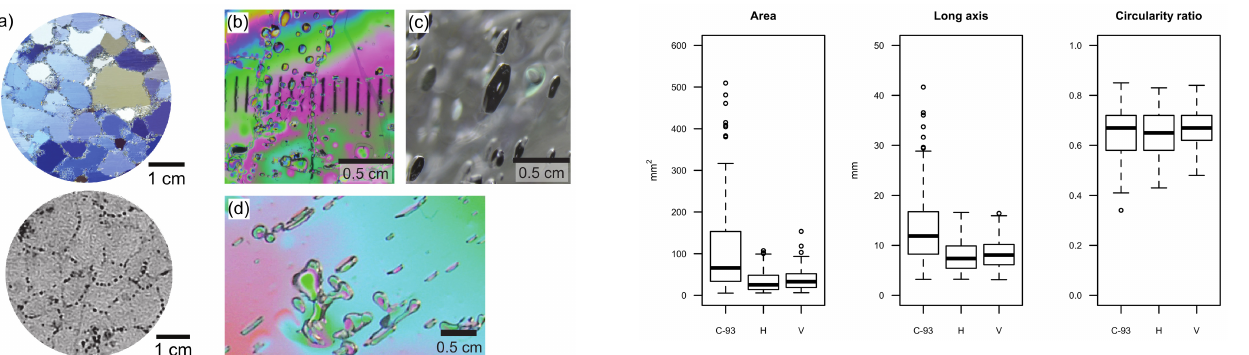
Figure 5. (a) A thin section of the massive ice viewed under cross- polarized light and a transverse cross section from a scan showing the gas inclusions within the ice. (air is black; ice is dark grey). Photos to the right show patterns of gas inclusions; (b) small (sub- millimetre to millimetre) spherical bubbles (vertical bars are from measuring ruler of microscope stage); (c) small disks up to 6mm in diameter; (d) coalescent bubbles and small disks all flattened in the same direction.